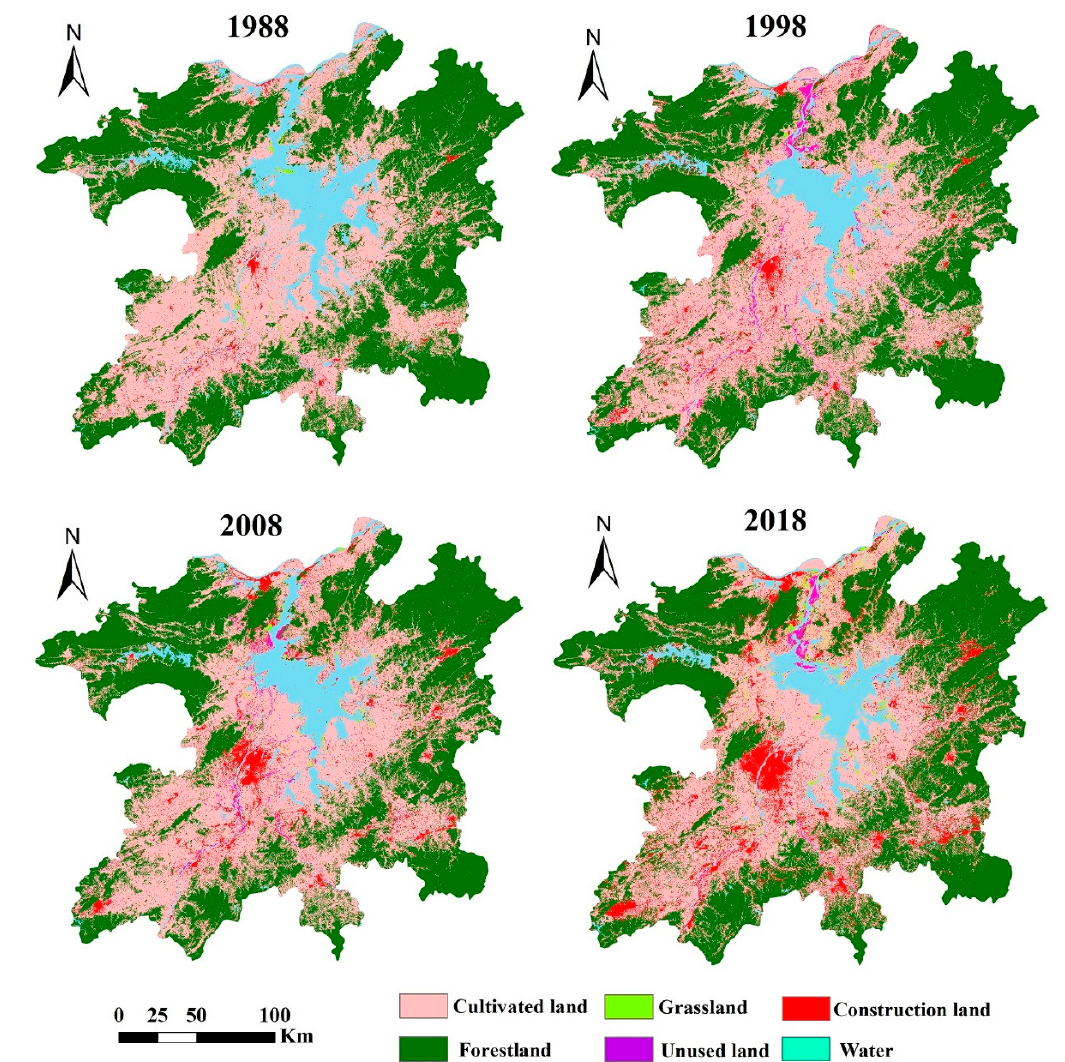
Figure 3. Spatial distribution of land use on the PLEEZ from1988 to 2018.